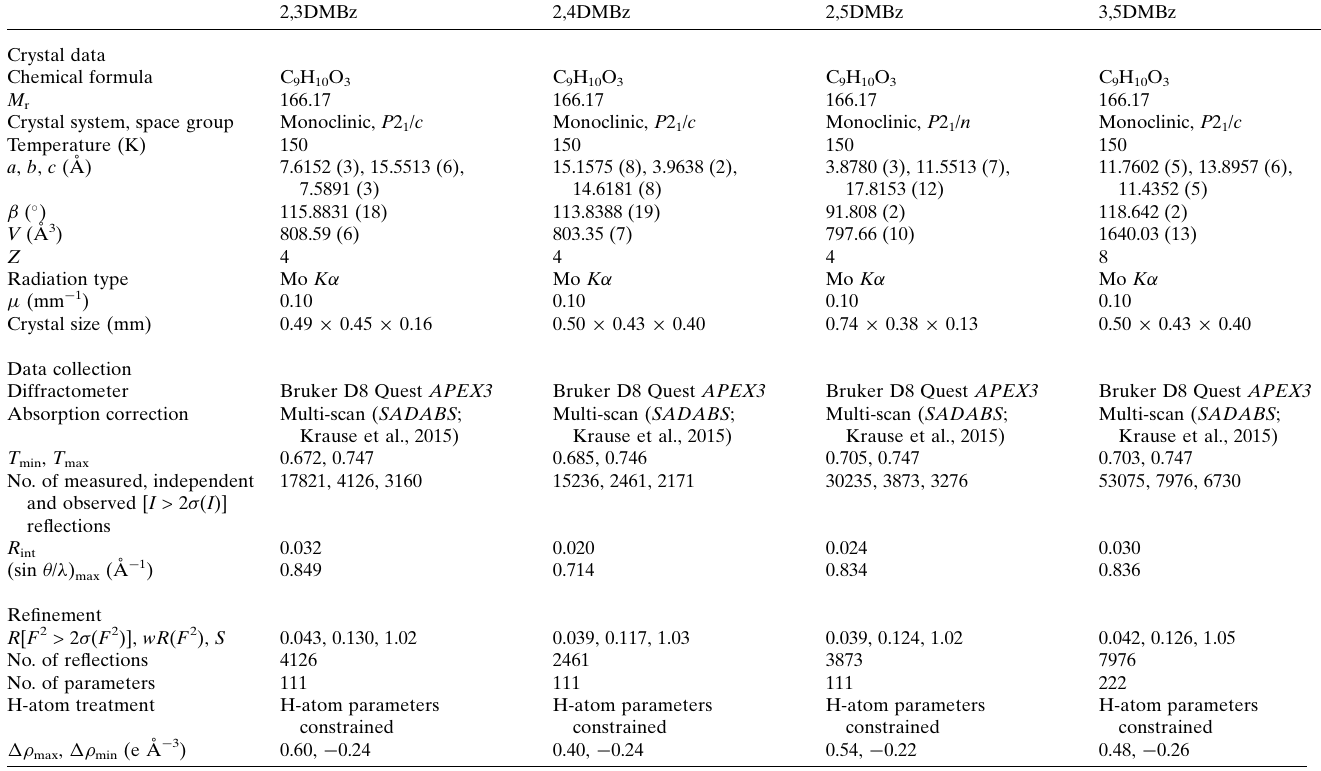
Table 3 Experimental